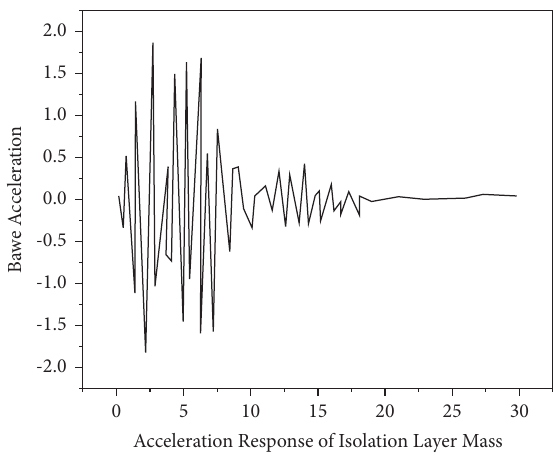
Figure 3: Excitation acceleration and response acceleration of Kobe seismic Table 1: Parameter identification results of rubber isolation layer model with different number of parameters under different seismic wave excitation.